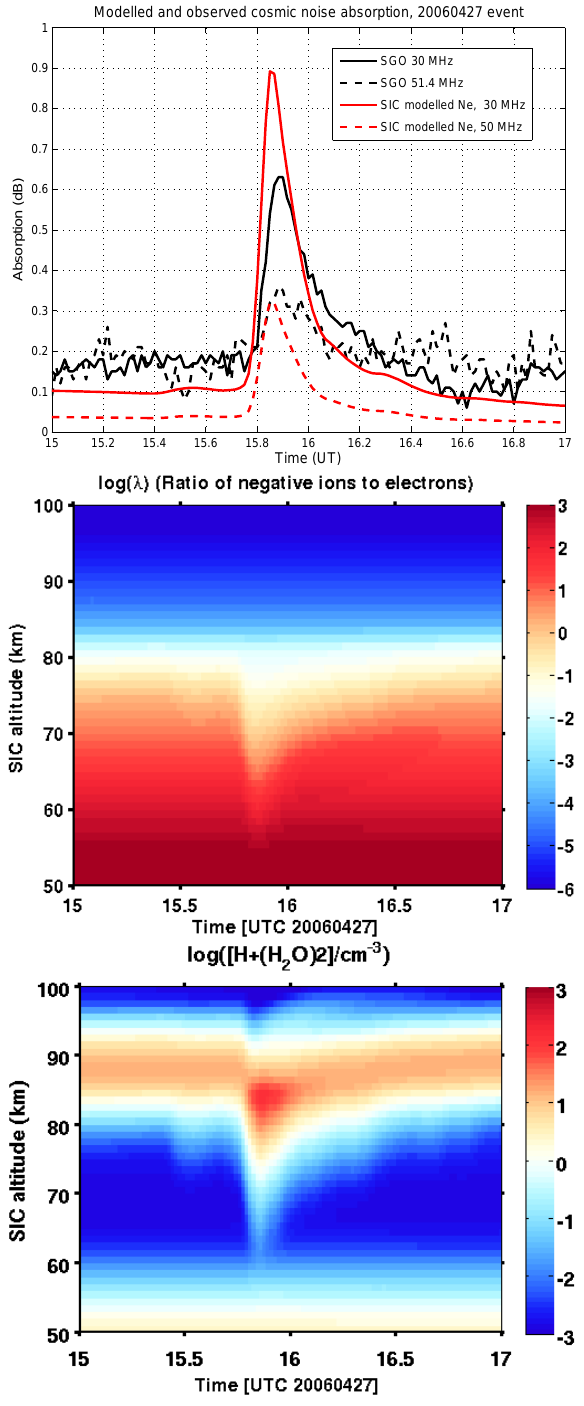
Fig. 9. SIC model results for the 27 April 2006 M6 flare event. Upper panel: Electron density. Middle panel: Ratio of negative ion to electron density. Lower panel: Concentration of the n = 2 proton hydrate, showing an increase of a few orders of magnitude in the mesopause region.